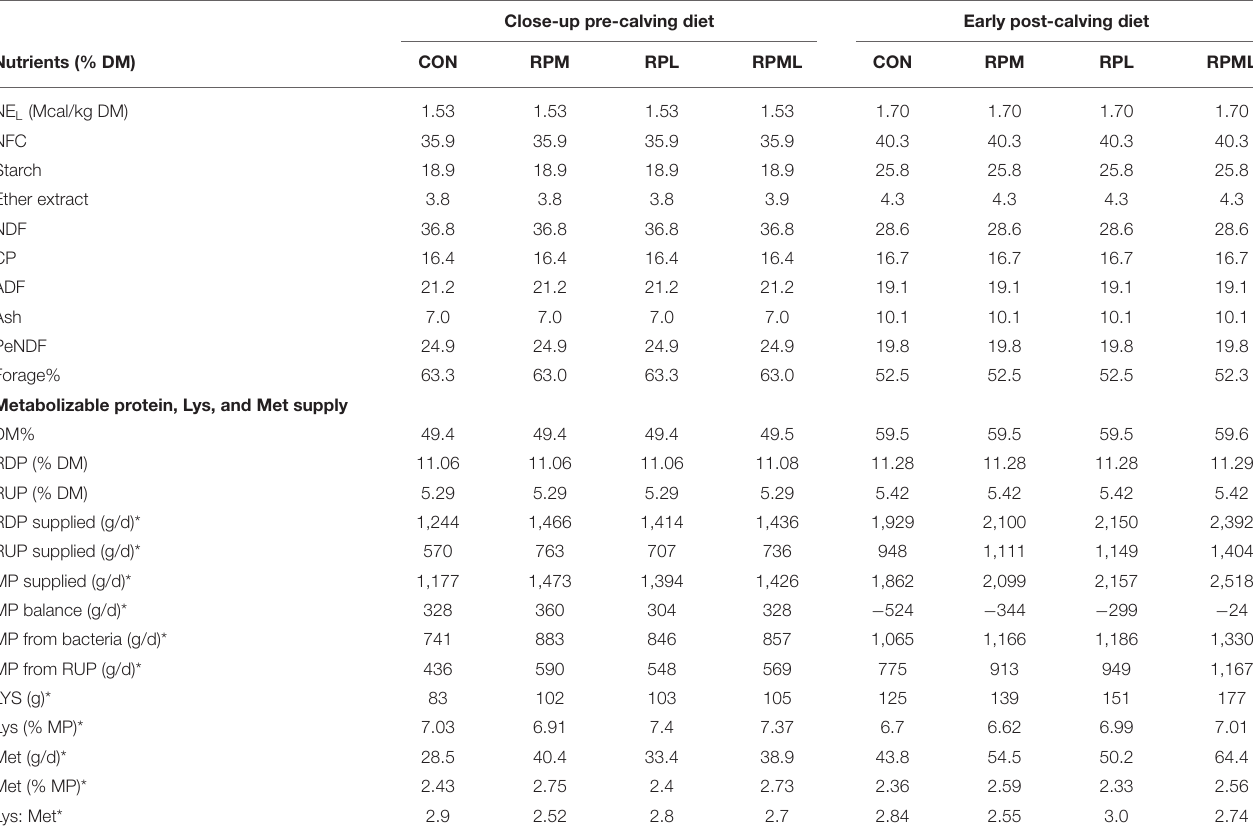
TABLE 2 | Chemical composition and predicted metabolizable protein, Lys, and Met supplies of the diets fed to Holstein cows during the transition period [close-up pre-calving diets (the last 3 wk before calving) to the early post-calving (the first 3 wk after calving)] a